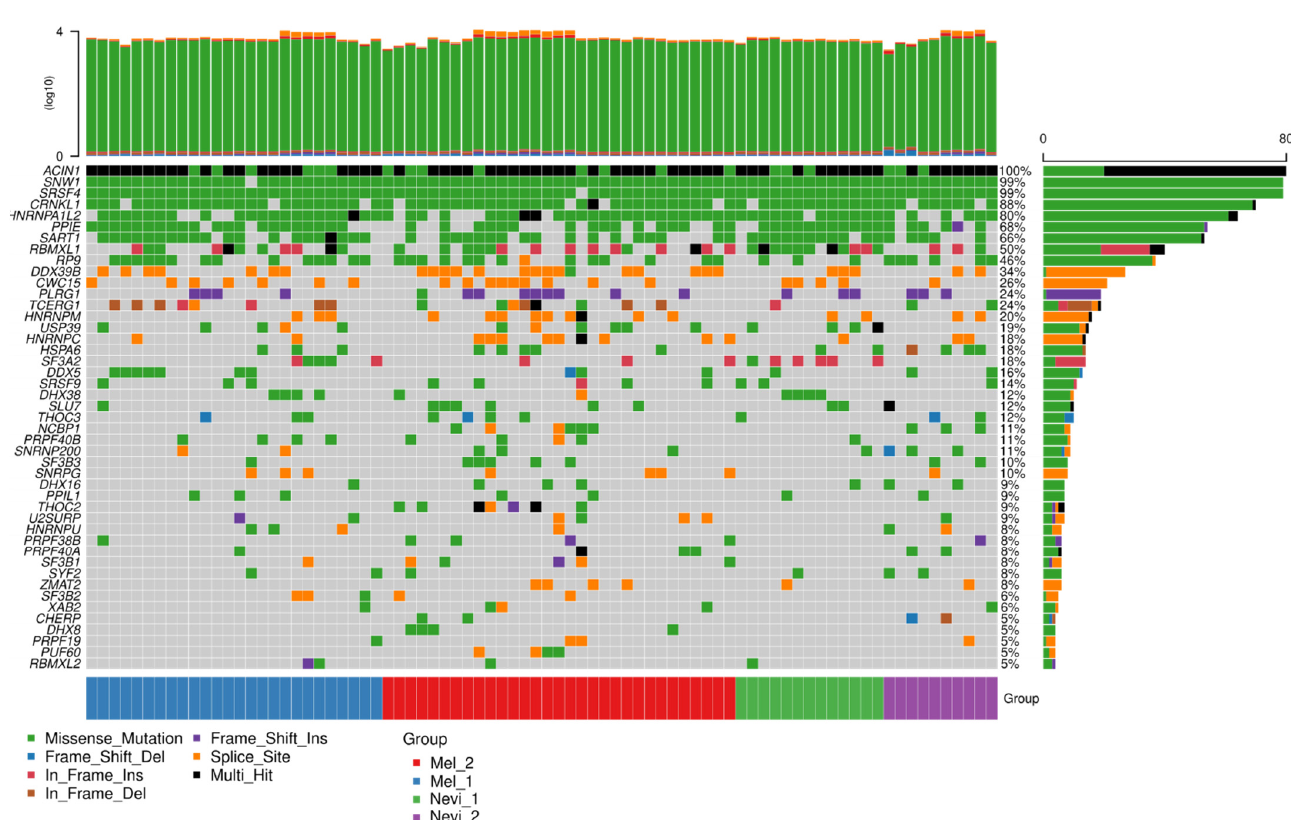
Figure 9. Mutational load of spliceosomal genes in the comparison of primary melanomas with benign melanocytic nevi. Mutational load of spliceosomal genes as annotated in the KEGG list at https://www.genome.jp/kegg-bin/show_pathway?ko03040, accessed on 4 December 2018.